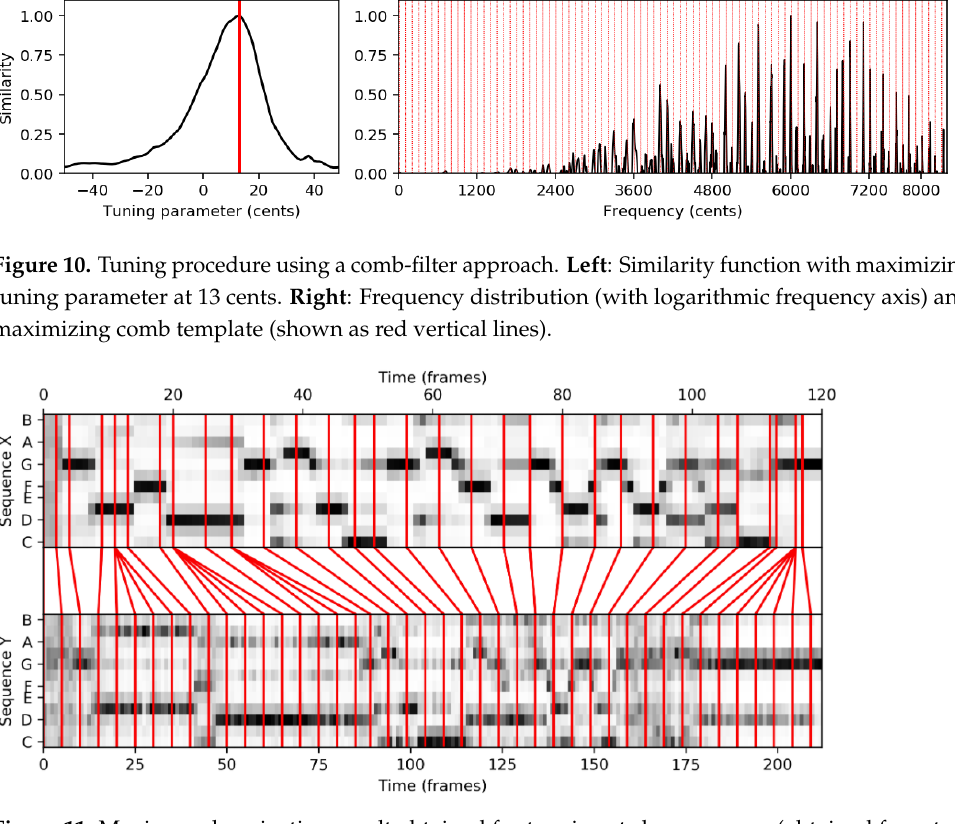
Figure 11. Music synchronization result obtained for two input chromagrams (obtained from two recordings of the beginning of Beethoven’s Fifth